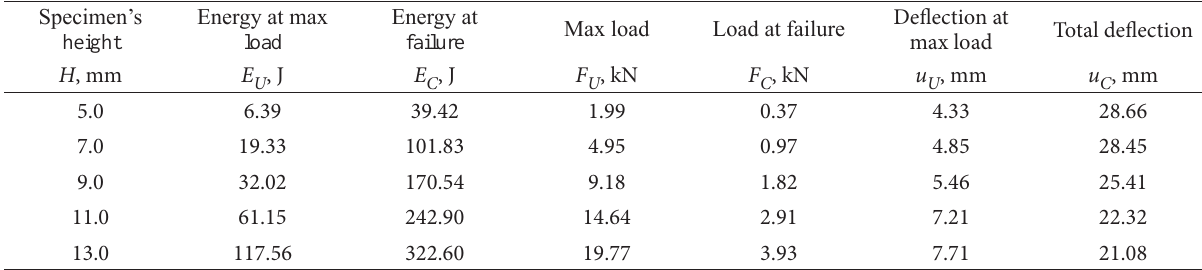
Table 3. Results of experiment Specimen’s height